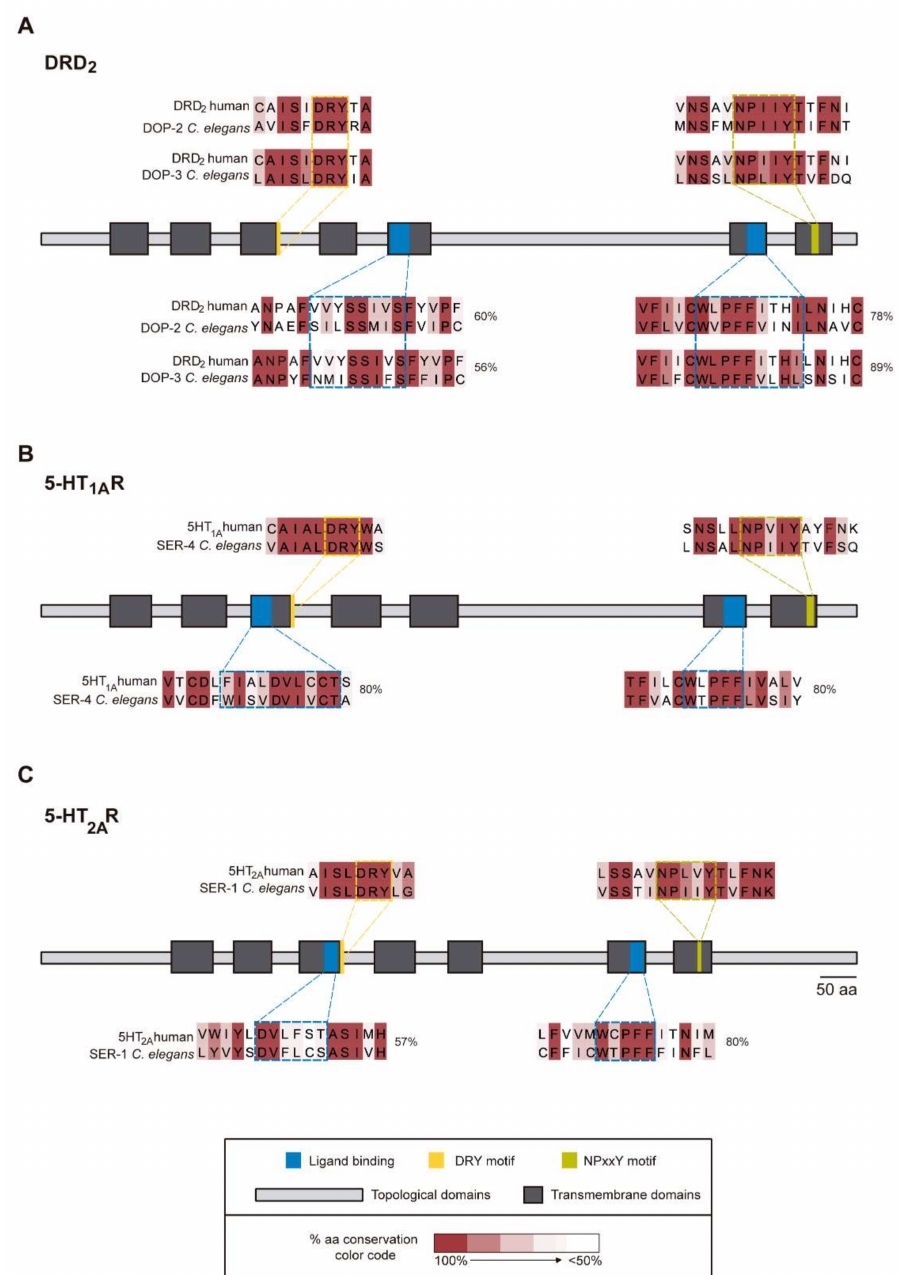
Figure 3. Alignments of human DRD 2 , 5-HT 1A R and 5-HT 2A R with their respective C. elegans orthologs. ( A ) DRD 2 and its orthologs, DOP-2 and DOP-3, ( B ) 5-HT 1A R and its ortholog, SER-4 and ( C ) 5-HT 2A R and its ortholog, SER-1, show conserved domain regions crucial for G-coupled receptors’ function, in particular, the ligand binding regions (blue), G-protein coupling region with the DRY motif (yellow) and the signal transduction region, with the NPxxY motif (green). Topological domains (light grey) contain intracellular or extracellular loops and seven transmembrane domains (grey) are also represented. Amino acid (aa) conservation between human and C. elegans is displayed in gradient color. Painted amino acids are within a threshold of 50% conservation, with the darkest red being 100% conservation, therefore corresponding to the same amino acid. Protein sequences were aligned using Jalview 2.11.1.3 Java Bioinformatics Analysis Server T-coffee, and amino acid conservation was also obtained from this program. Percentage of similarity of the ligand binding region between human and C. elegans receptors is